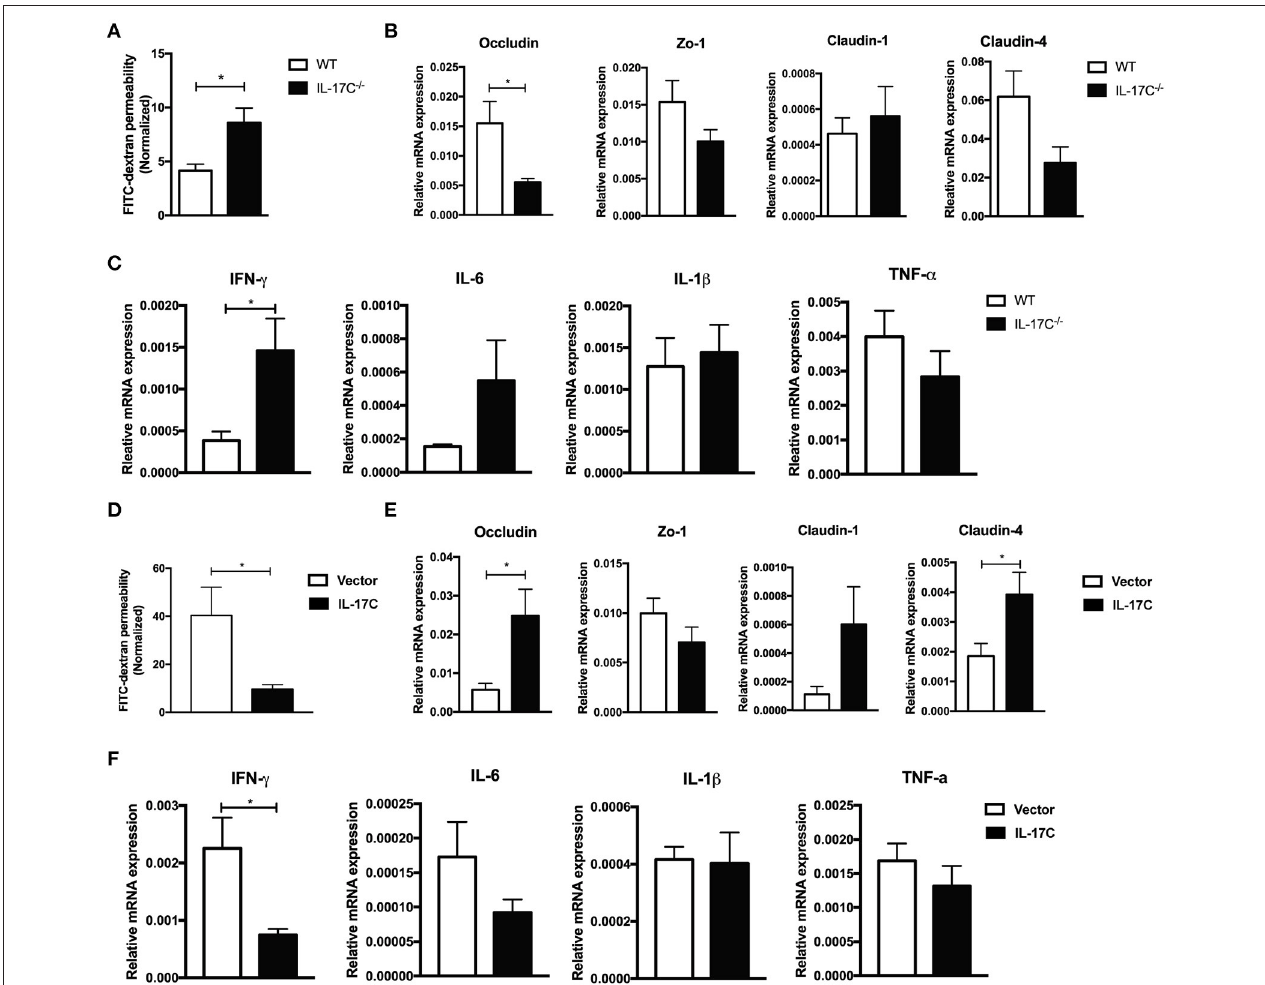
FIGURE 4 | IL-17C maintains intestinal epithelia integrity and suppresses inflammation . BALB/c recipients were lethally irradiated and transplanted with 1 × 10 ∧ 7 bone marrow cells and 5 × 10 ∧ 6 splenocytes from WT or IL-17C − / − mice, respectively. Recipients were fasted for 4h prior to delivering 600 mg/Kg FITC-dextran via gavage 7 days post-transplantation. ( A ) The FITC-dextran concentration in serum was measured 4h after infusion 7 days post-transplantation; n = 5 per group. ( B ) Total RNA from aGVHD target tissues was extracted and reversed into cDNA. Tight junction protein ( B ) and inflammatory cytokine ( C ) expressions were detected by real-time PCR; n = 4–5 per group. ( D ) BALB/c recipients were injected with vector plasmid or minicircle-IL-17C plasmid 3 days before transplantation, and then transplanted with 1 × 10 ∧ 7 bone marrow cells and 5 × 10 ∧ 6 splenocytes from B6 WT donors. Serum FITC-dextran concentration was measured on day 7 using the same method described before; n = 5 per group. Tight junction protein ( E ) and inflammatory cytokine ( F ) expressions in spleen, liver, lung, and intestine were detected by real-time PCR on day 7; n = 4 per group. Data are representative of at least three experiments and presented as mean ± SEM. * P < 0.05.